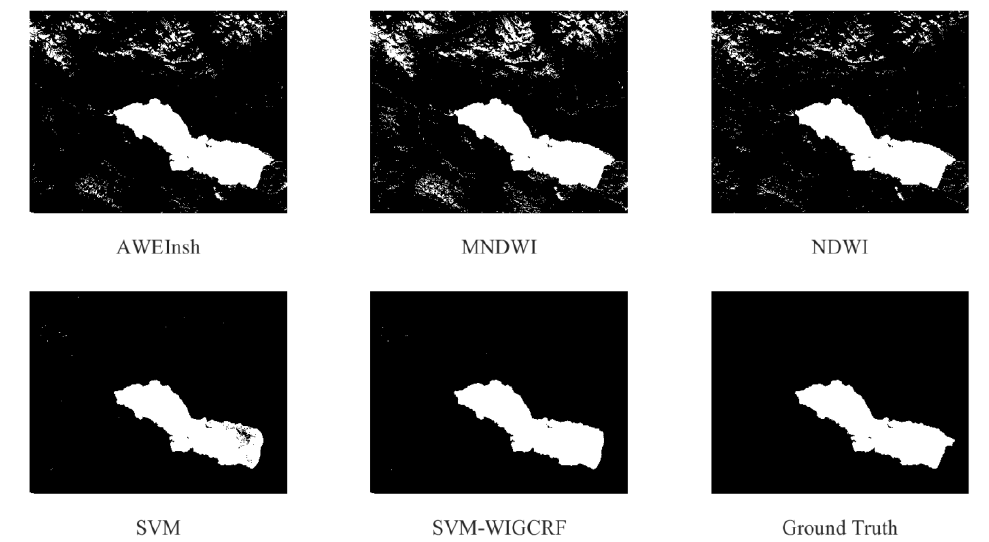
Figure 3 . Water extraction results achieved by different methods. Traditional WI methods are sensitive to ice/snow lead to a lower accuracy than other methods. SVM performs better than WIs, but is still affected by ice/snow and yields many false alarms. SVM- WIGCRF achieve the best result and produces a clean background.